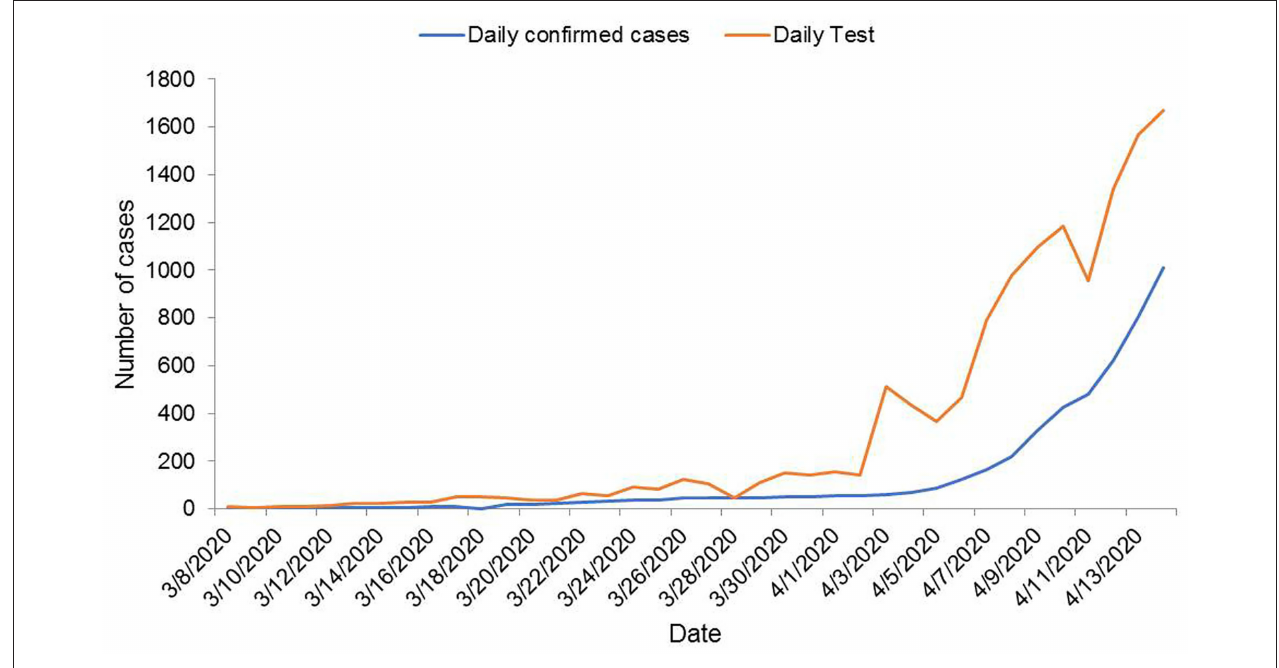
FIGURE 3 | A plot of new confirmed COVID-19 cases vs. tests performed on a daily basis in Bangladesh until 14 April